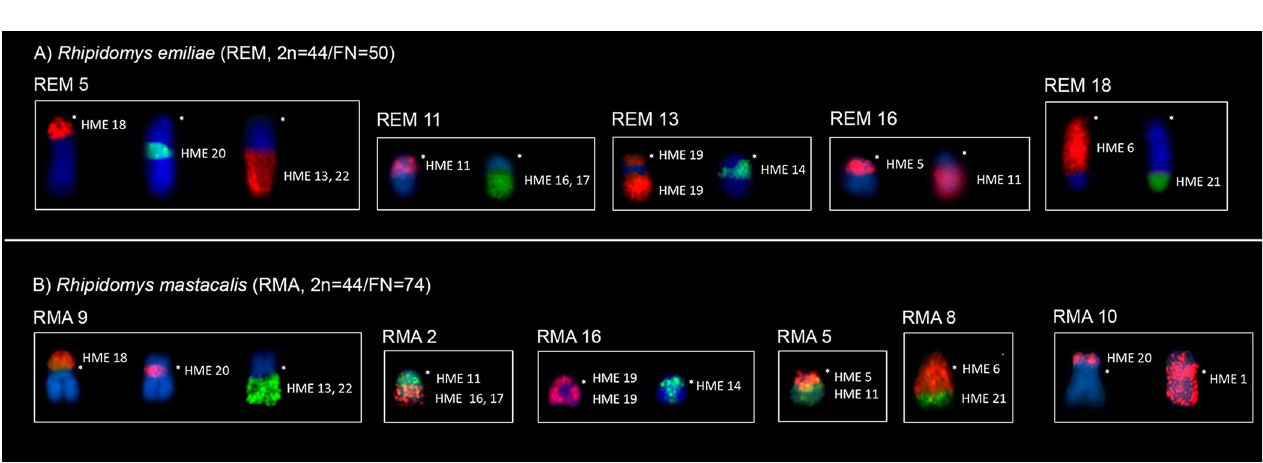
Fig 5. Chromosomal associations shared between (A) R . emiliae and (B) R . mastacalis using HME probes ( REM 5 and RMA 9 / REM 11 and RMA 2 / REM 13 and RMA 16 / REM 16 and RMA 5 / REM 18 and RMA8). Additionally, the association HME1/HME20 (RMA 10) not found in REM is evident. Each box shows a chromosome pair with syntenic association. ( � ) Indicates a centromere.